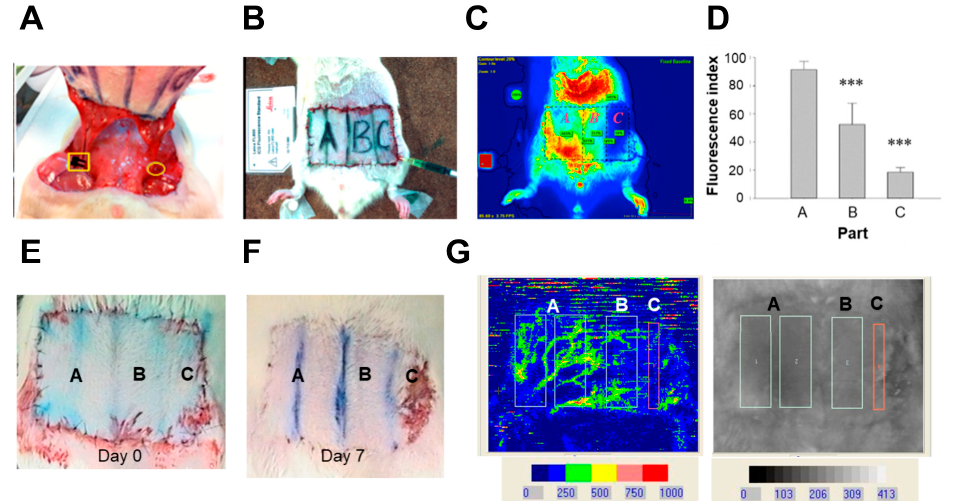
Figure 1. Evaluation of blood flow via indocyanine green (ICG) fluorescence and laser Doppler imaging after flap surgery. ( A ) The right epigastric vessel was ligated by Nylon 5-0 (yellow circle). The yellow square indicates the use of bulldog badge clamp over the left epigastric vessel for 1 h for ischemic manipulation. The manipulation mimics free flap surgery and partial ischemic failure. The rat subjected to ICG fluorescence imaging under ( B ) white light and ( C ) ICG fluorescence imaging. All flaps were divided into Parts A, B, and C. Part A indicates sufficient-vascularity, Part B indicates borderline-vascularity, and Part C indicates insufficient-vascularity; ( D ) Quantification of ICR imaging ( n = 4). The images of rat skin at ( E ) day 0, and ( F ) day 7 post-operation. The Part B was shrunk and Part C showed the partial necrosis of the skin flap at day 7 (the red rectangle); ( G ) The region of LASER Doppler quantification. Data is shown as mean ± standard error of the mean (SEM). *** p < 0.001 significantly different from the Part A.